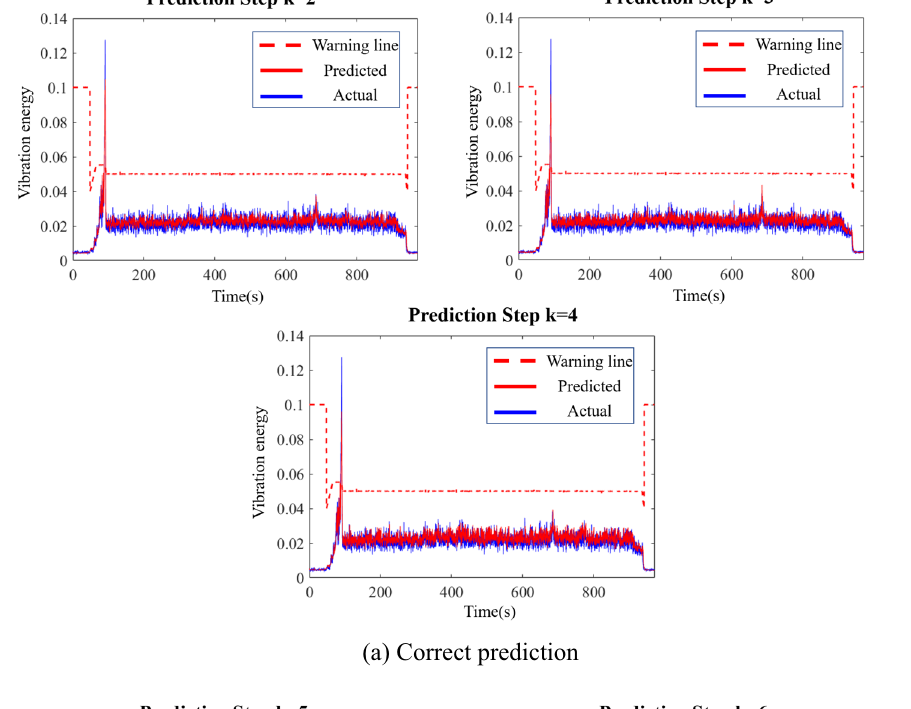
Fig. 11 The influence of pre- diction